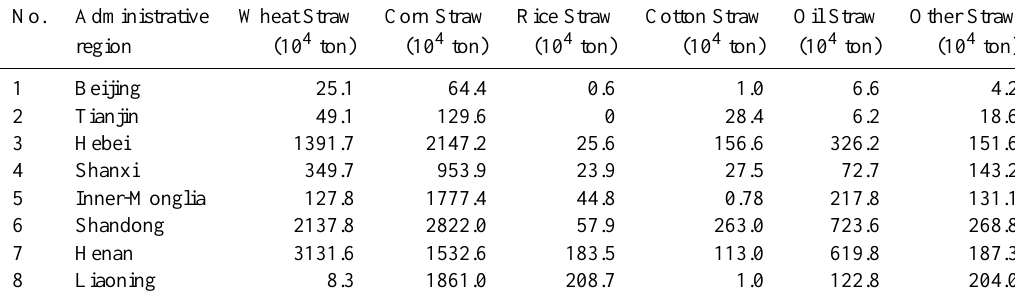
Table 4. Annual straw masses burned in the larger Huabei region in 2003.